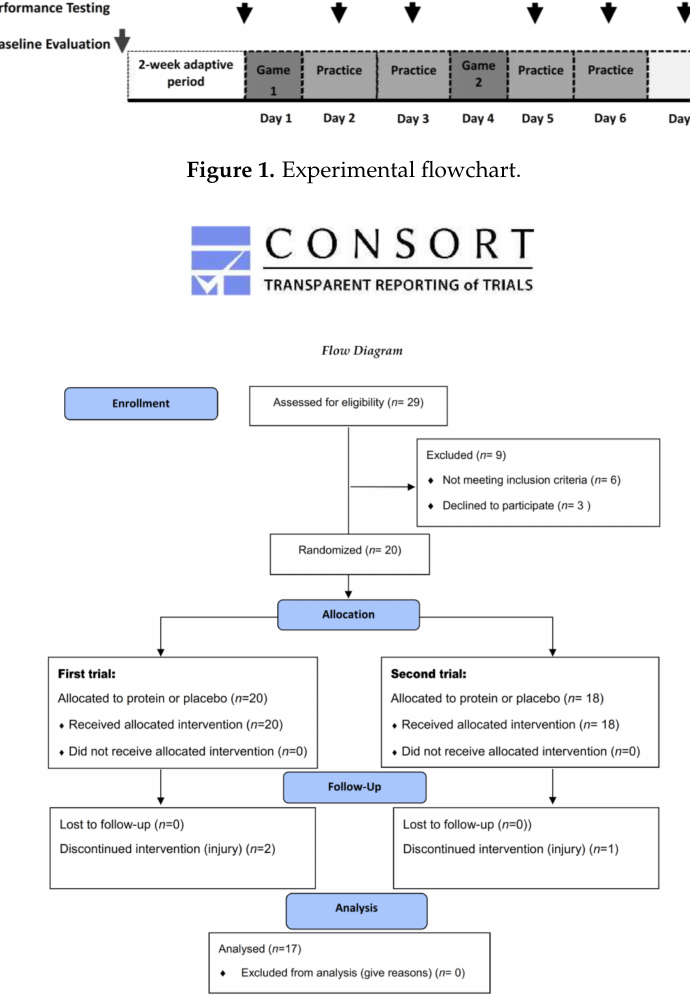
Figure 2. CONSORT 2010 flow